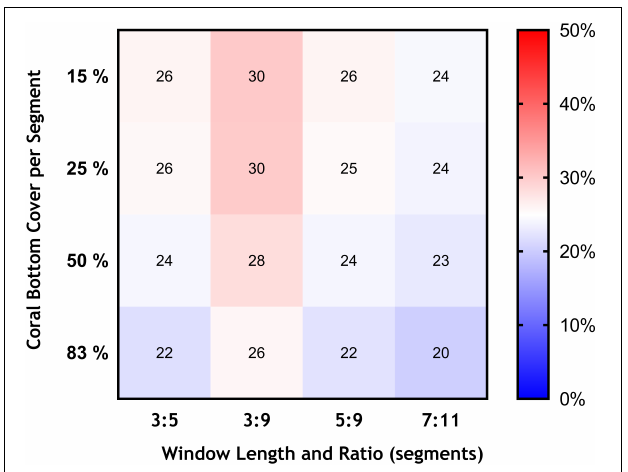
FIGURE 6 | Effects of changing the bottom cover of coral matrix (from 15 to 83%), and the length of the moving window and ratio of VME habitat segments required within its length (3:5 base-case and 3:9, 5:9, and 7:11) in terms of the area of VME habitat identified across transects expressed as percentage of total area surveyed (color